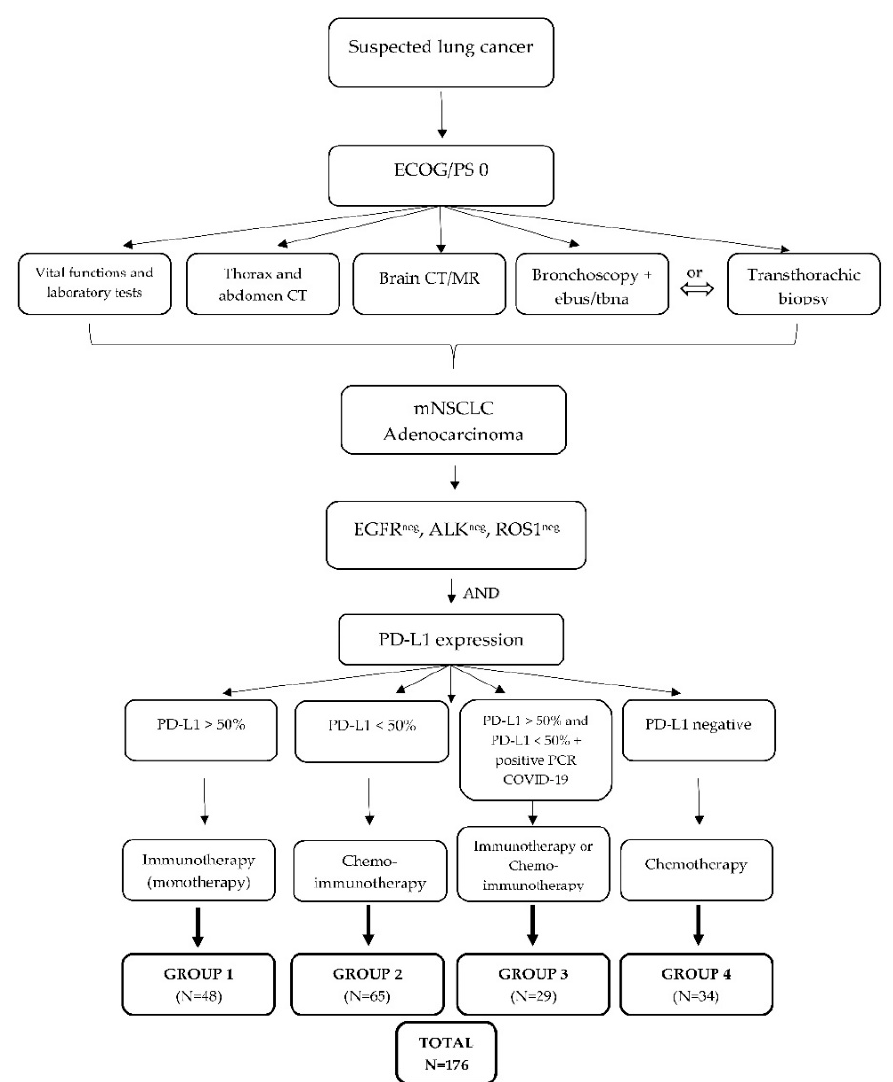
Figure 1. Study algorithm and classification of groups of patients. ECOG/PS, ECOG performance status; mNSLC, metastatic non-small-cell lung carcinoma; EGFR, epidermal growth factor receptor; ALK, anaplastic lymphoma kinase; PD-L1, programmed death-ligand 1.